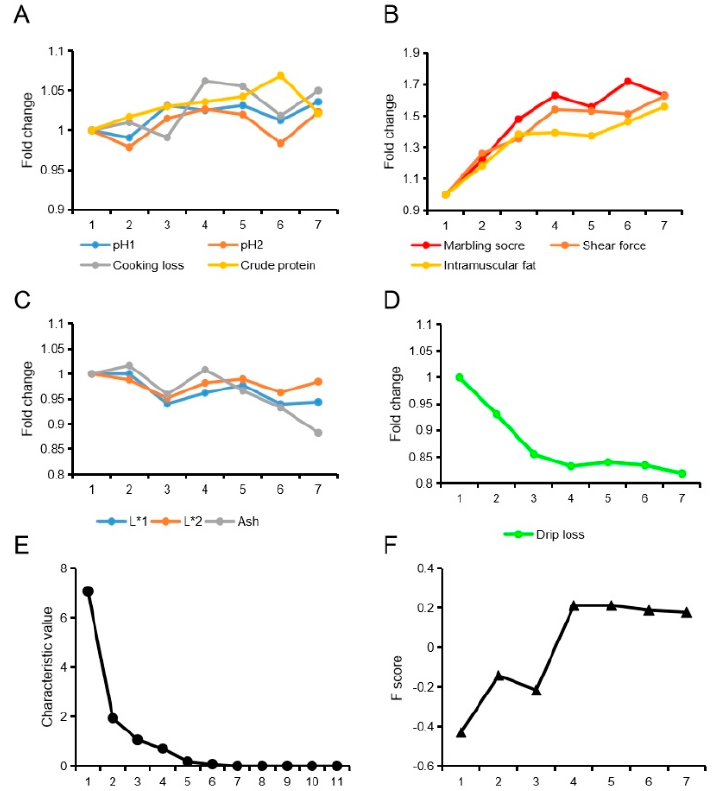
Figure 1. Change pattern of Liangshan pig meat quality traits. ( A ) Slowly increasing meat quality traits. ( B ) Rapidly increasing meat quality traits. ( C ) Slowly falling meat quality traits. ( D ) Rapidly falling meat quality traits. ( E ) Crushed stone graph for factor analysis of meat quality traits. ( F ) Comprehensive score for factor analysis of meat quality